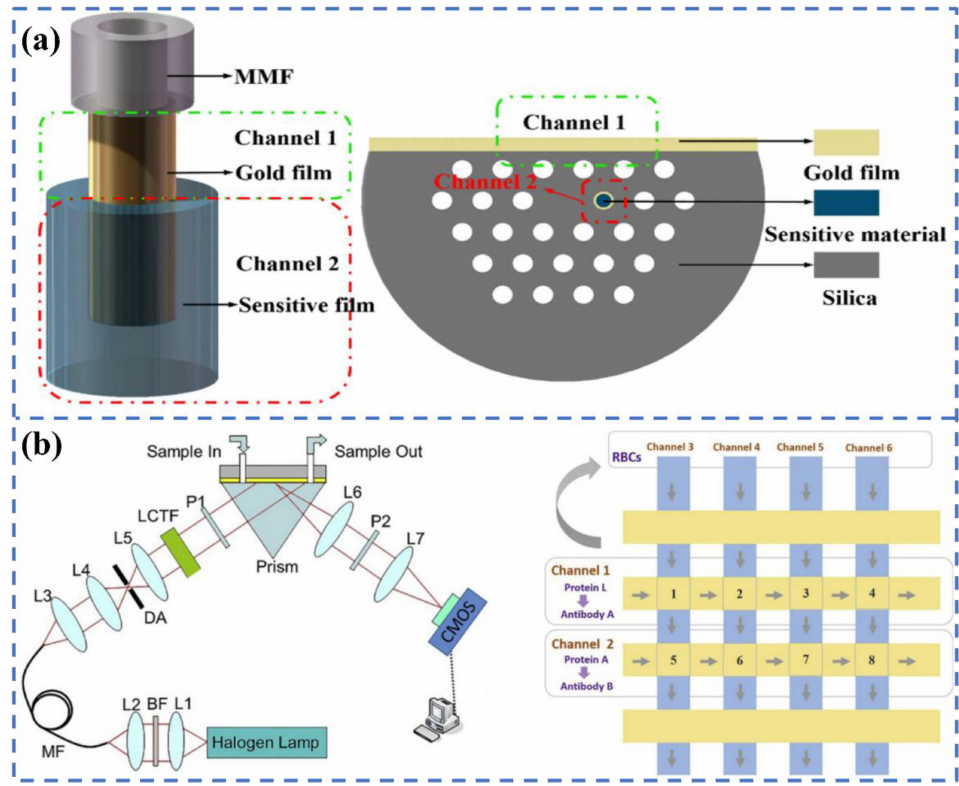
Figure 12. ( a ) Schematic diagram of the multi-channel SPR sensor. Reprinted with permission from ref. [129]. Copyright 2022, Wiley. ( b ) Diagram of the SPR imaging system for the detection of blood typing. Reprinted with permission from ref. [130]. Copyright 2020,